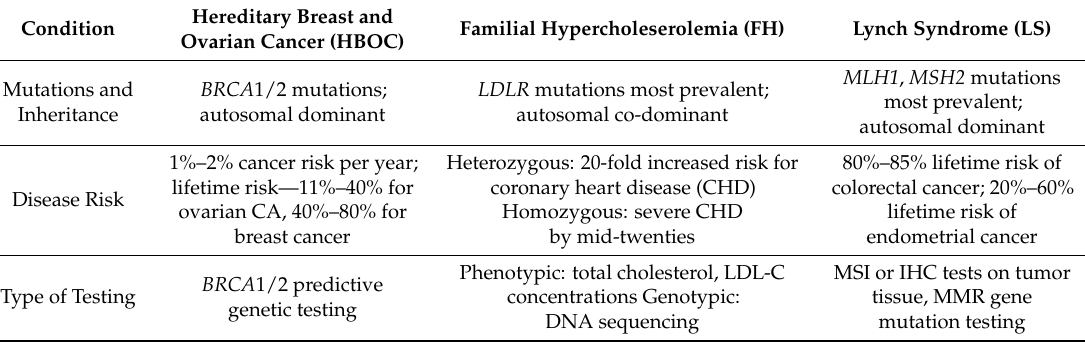
Table 1. Tier 1 genetic tests and